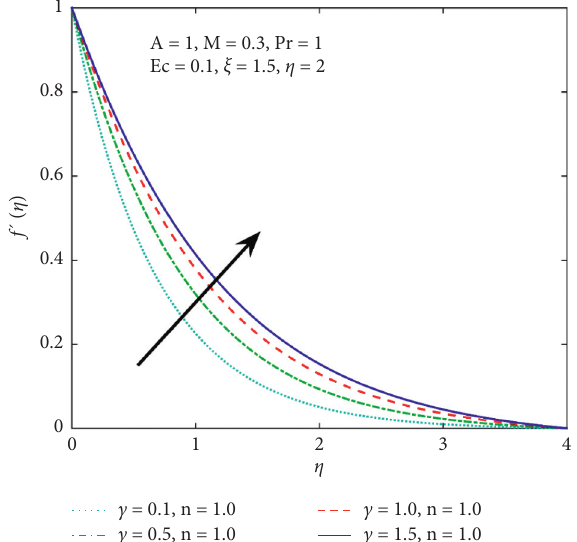
Figure 3: Velocity profile f ′ ( η ) for different values of curvature parameter ( c )